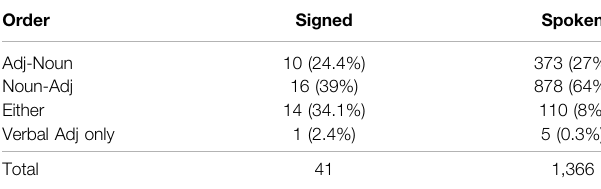
TABLE 3 | Noun/Adjective order in signed and spoken